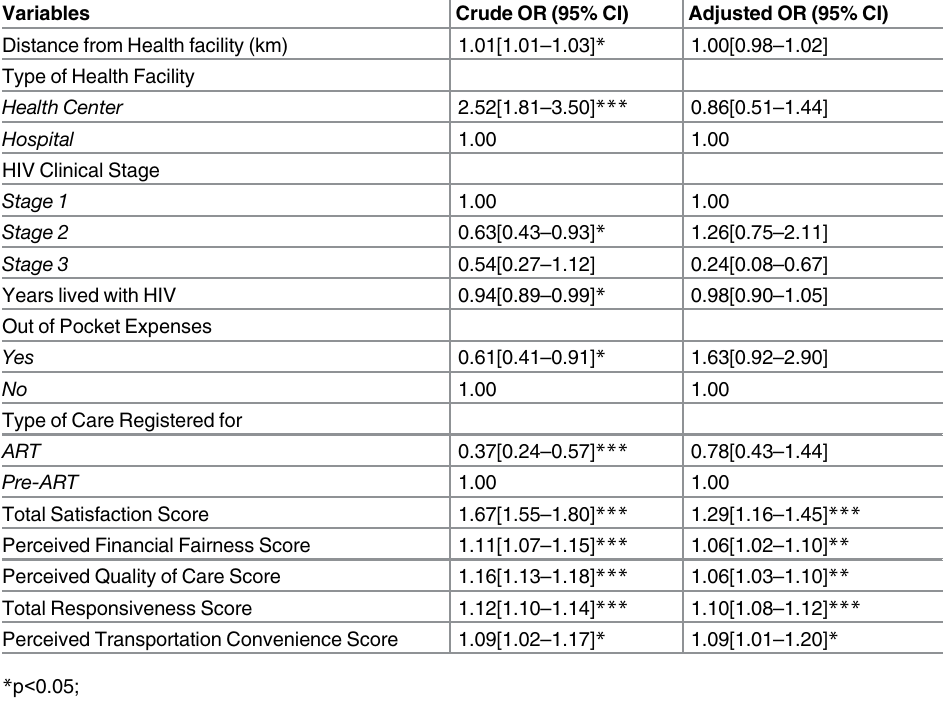
Table 3. Bivariate and Multivariate Analysis of Factors Associated with Perceived Access to HATCS, Wolaita Zone (Ordinal Logistic Regression